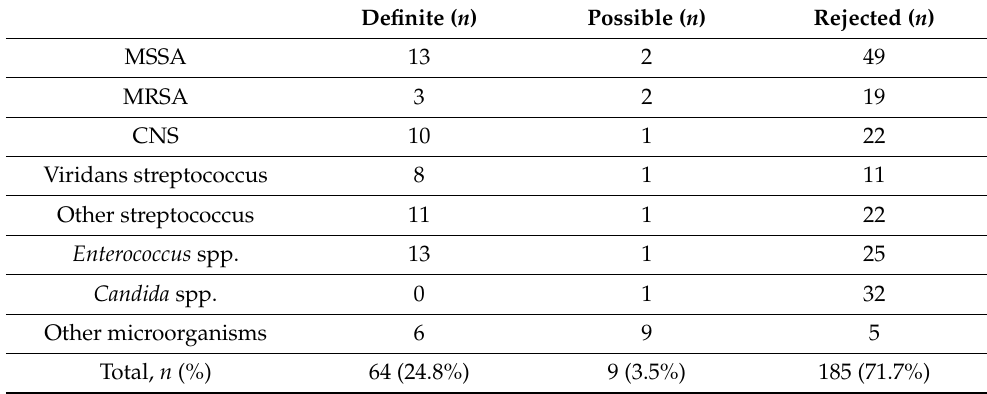
Table 3. Proportion of cases of IE caused by different microorganisms.